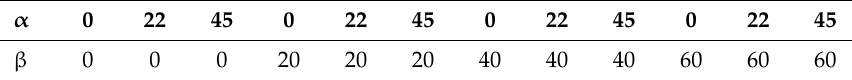
Table 1. Field angles used in the simulation presented in Figure 9.